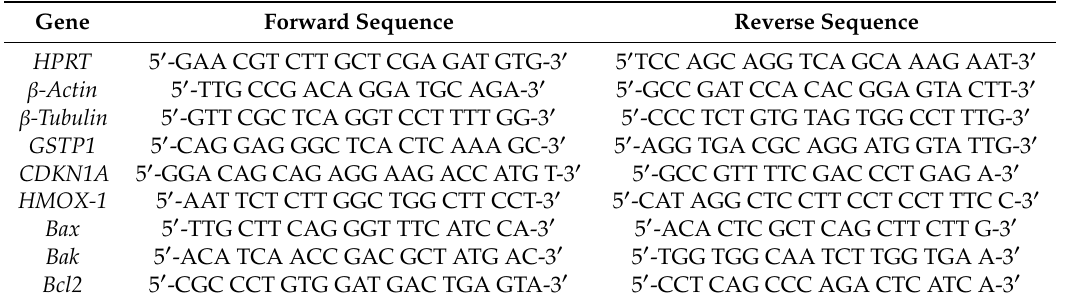
Table 1. Primer sequences used for measuring mRNA expression via quantitative polymerase chain reaction. Gene Forward